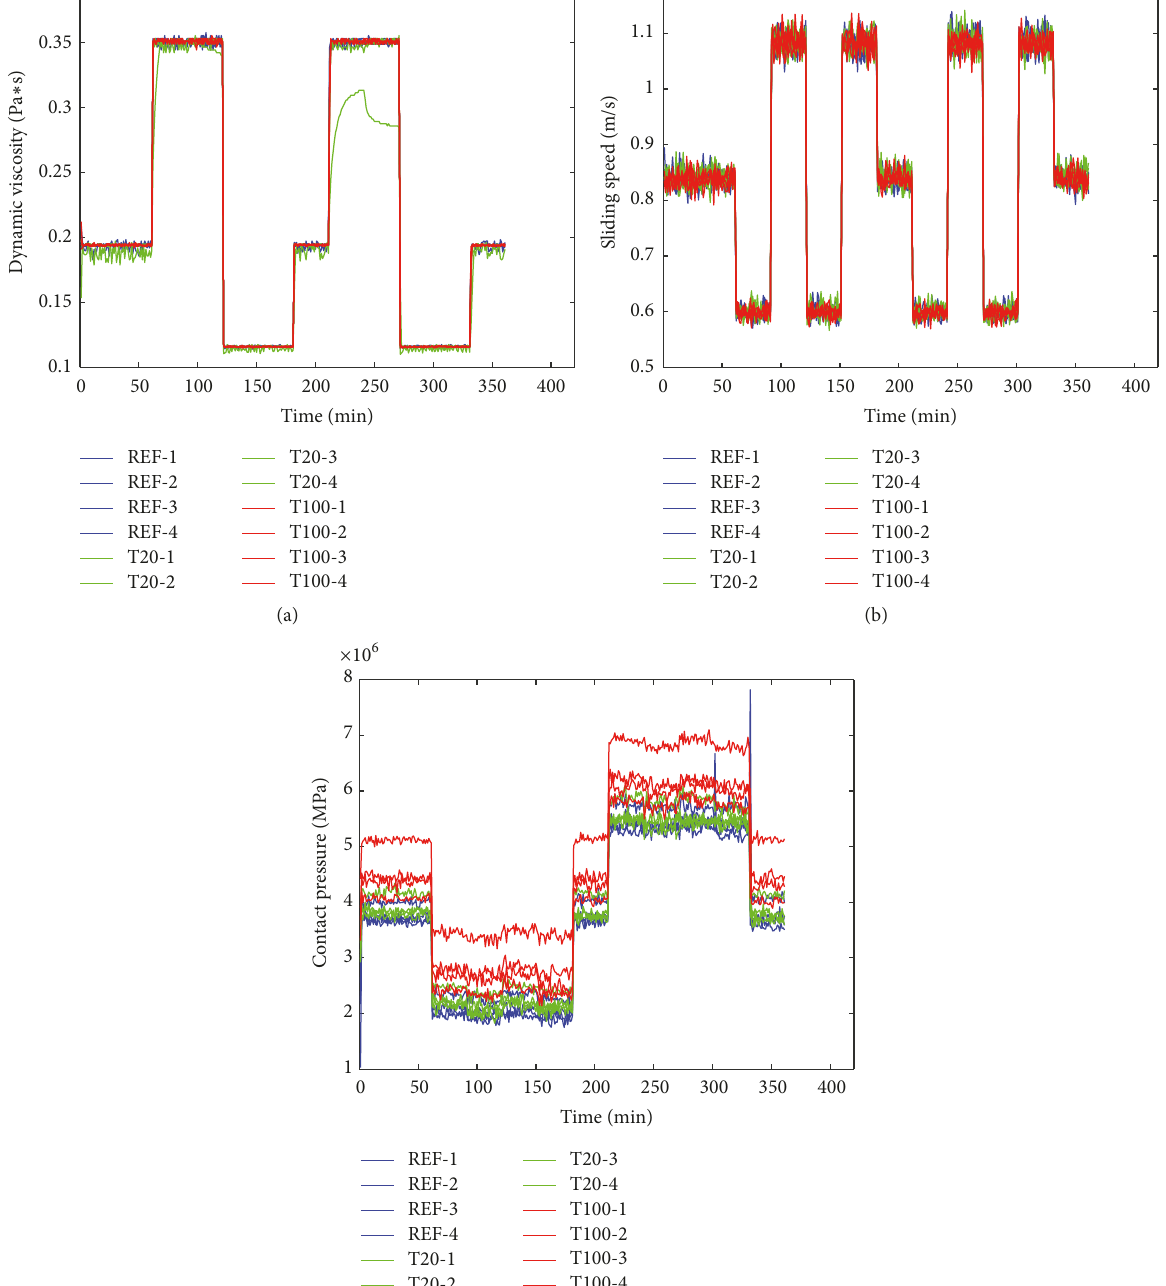
differences are present for textured surfaces with shift towards the boundary lubrication regime; however, at low contact pressure and high viscosity, the friction increases with increased sliding speed for all investi- gated surfaces; thus, a shift towards the hydrodynamic lubrication regime is present for this contact condi- tion for all surfaces, textured or